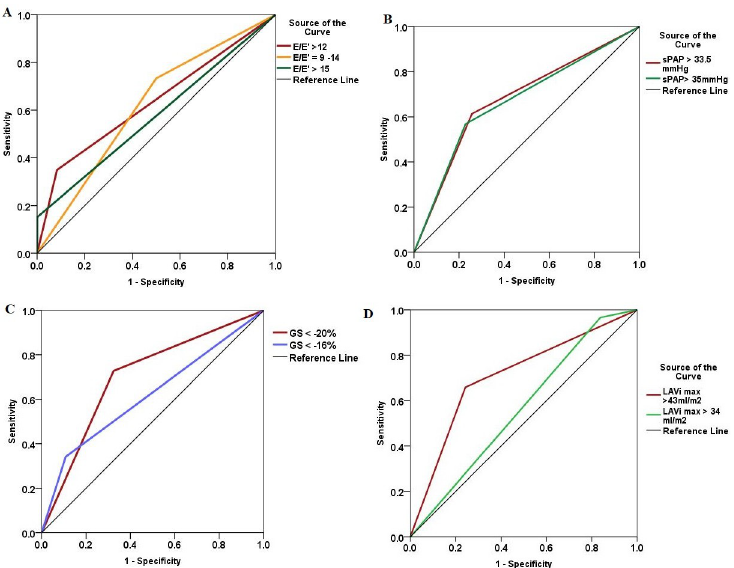
Fig 3. Comparative receiver-operating curves of the conventional echocardiographic parameters for HFpEF diagnosis, between new-proposed and old cut-off values. Panel A . E/E’ ratio > 12 registered a higher accuracy (AUC = 0.633), compared to the old values 9–14 (AUC = 0.616) and > 15 (AUC = 0.576); Panel B . Systolic pulmonary artery pressure (sPAP) > 33.5 mmHg (AUC = 0.678) showed a slightly higher accuracy compared to the guidelines value > 35 mmHg (AUC = 0.670). Panel C . Global strain (GS) < -20% demonstrated a significantly higher AUC = 0.727, compared to the consensus proposed value of < -16%; Panel D . Left atrial maximal volume indexed (LAVimax) > 43 ml/m 2 predicts better patients with HFpEF, by comparison to the conventional cut-off value > 34 ml/ m 2 .